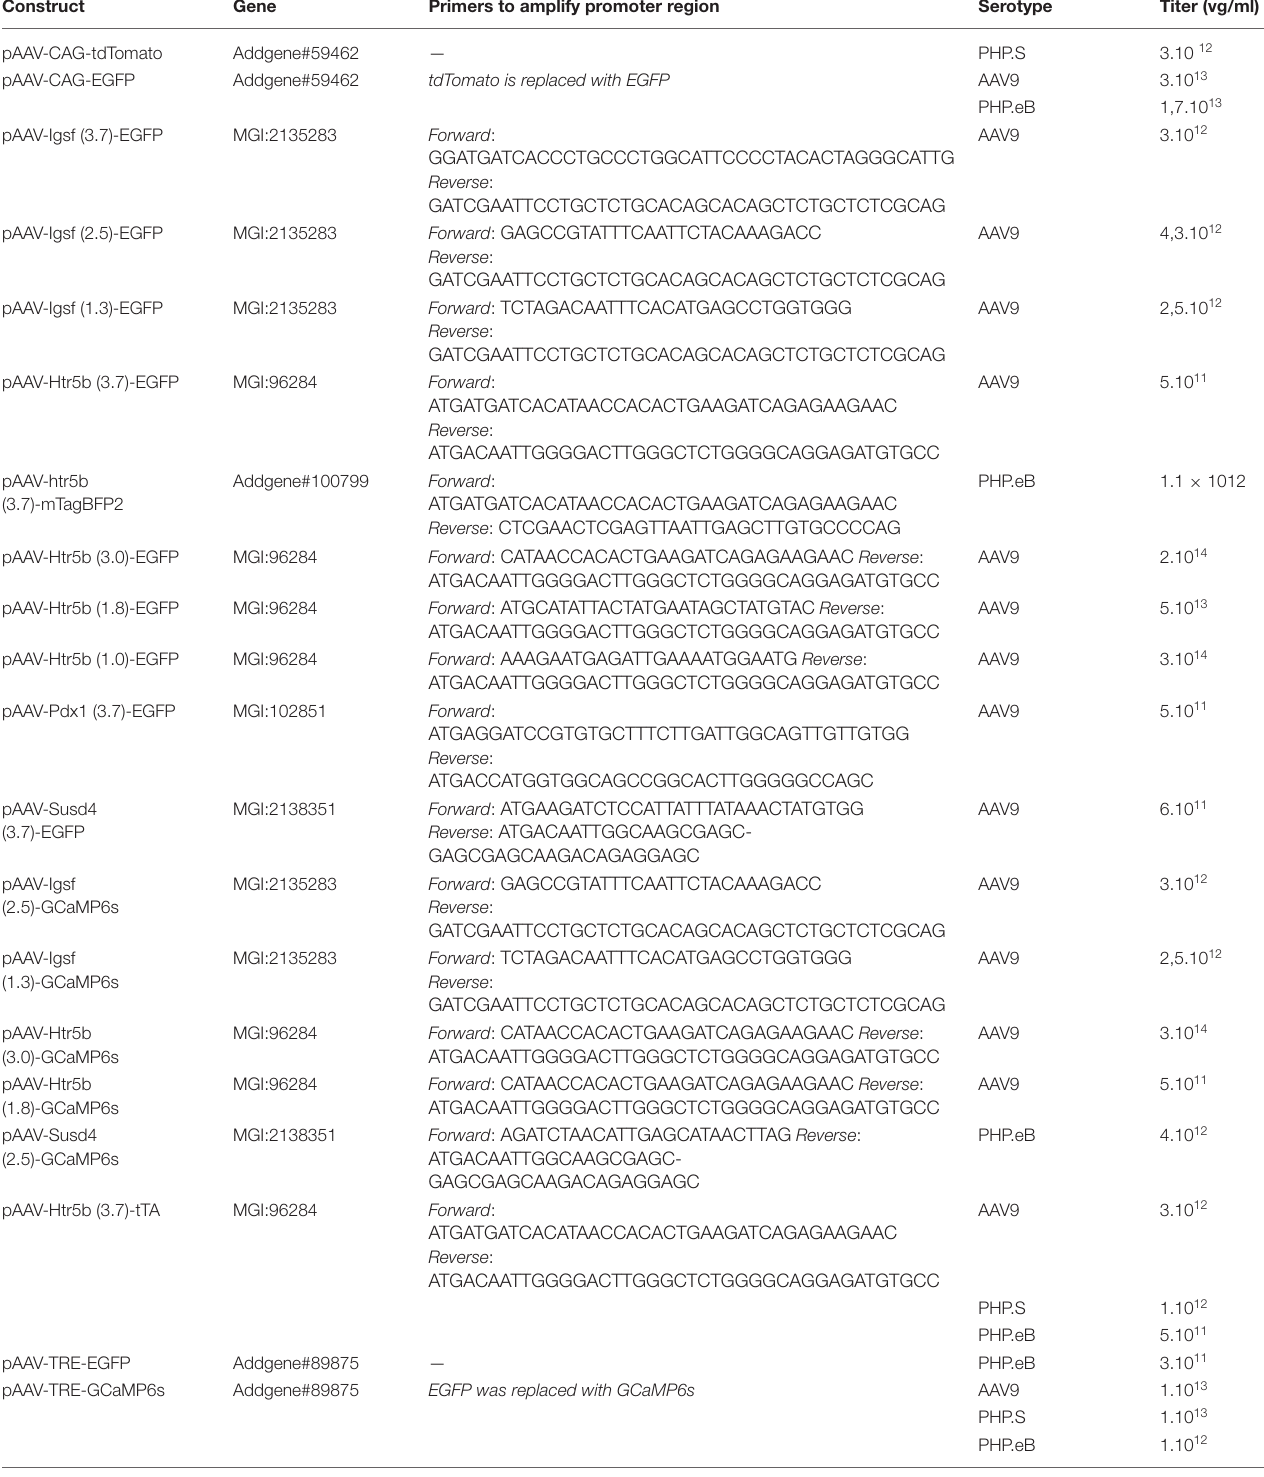
TABLE 1 | List of custom AAV vectors used for anatomical and functional characterization of IO by “single-AAV” and “double-AAV” approaches.